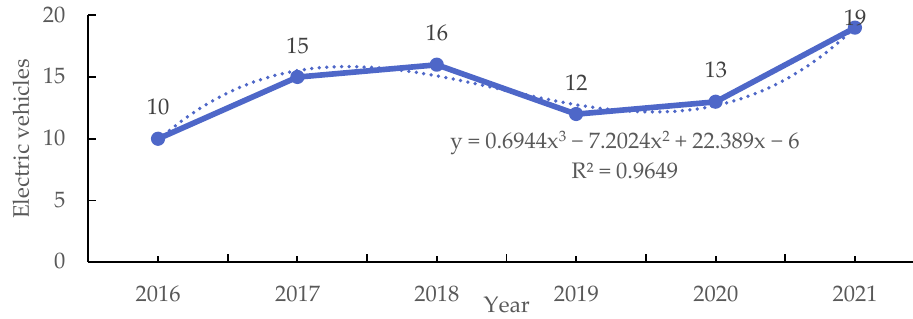
Figure 10. The trend line for the projection of EVs in the city of Cuenca [24,25].